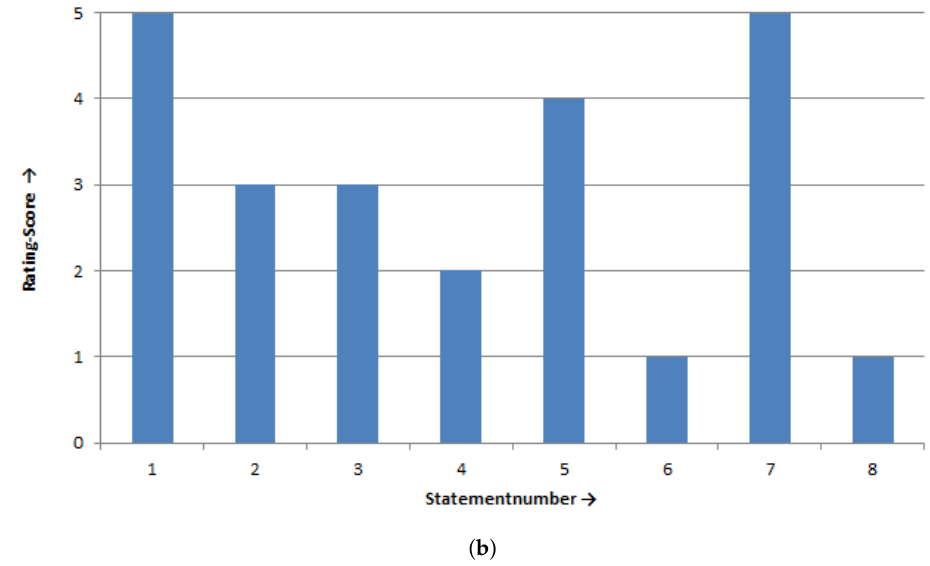
Figure 11. Results of the subjective questionnaire for the use-case, scale from 1 “I do not agree at all” to 5 “I totally agree”: ( a ) able-bodied subjects, mean values ± SE of the rating scores of the eight statements; and ( b ) subject with tetraplegia, values of the rating scores of the eight